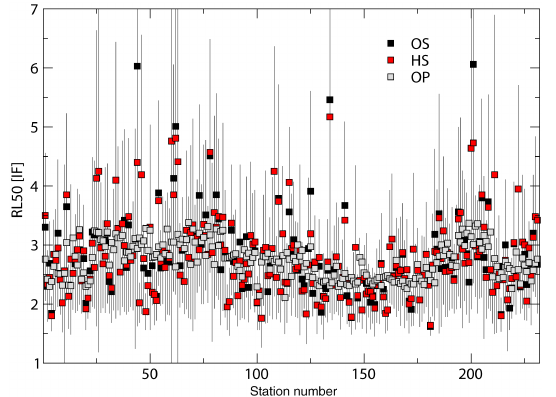
Figure 5. Rescaled RL50s (IF units) for any station site, obtained from both original (OS) and homogenized records (HS) at the single-station level, and compared with expected RL50 from the pooled-station samples (OP). Only error bars of OS RL50 are shown, as they largely overlap with HS errors and completely mask those of the OPs.